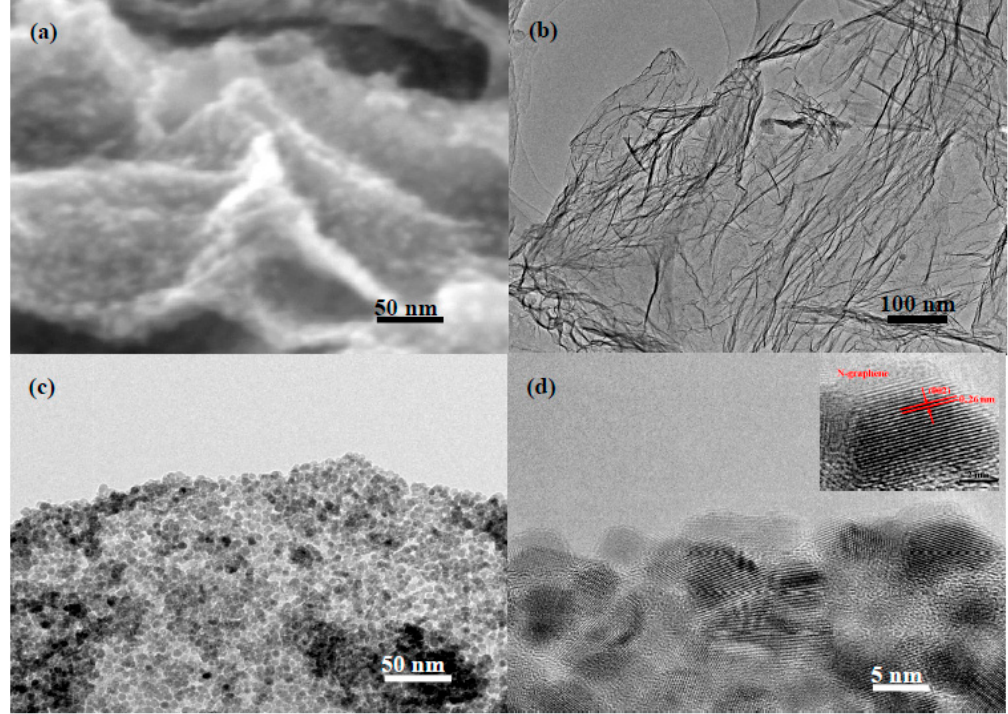
Figure 3. ( a ) SEM image of the ZnO/NG composite, TEM images of ( b ) NG and ( c , d ) ZnO/NG composite.